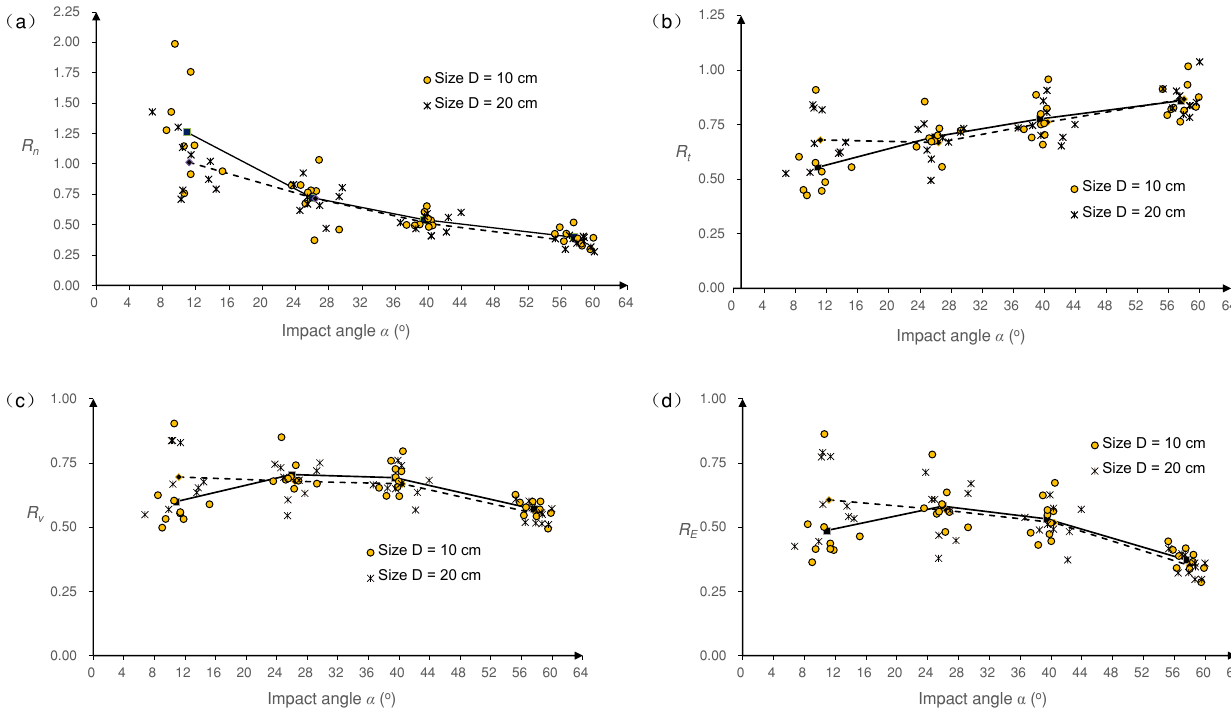
Figure 5. The variations of four coefficients of restitution: (a) the normal coefficient R n , (b) the tangential coefficient R t , (c) the kinematic coefficient R v and (d) the kinetic energy coefficient R E , with the impact angle α in this study, and the mean value lines for samples with size D = 10cm (solid lines) and D = 20cm (dashed